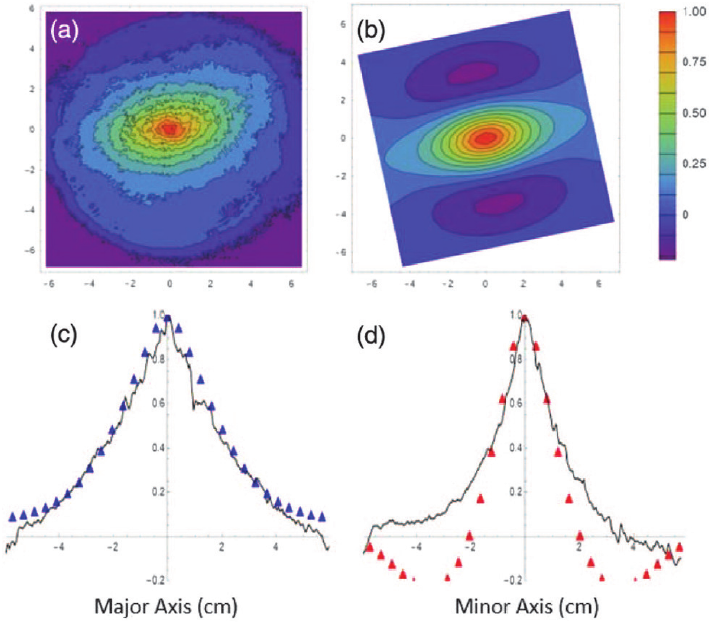
Figure 4. Experimental field measurements compared with theoretical results showing anisotropy ellipse of intensity covariance function: ( a ) measurement; ( b ) theory; ( c , d ) are major and minor cross-sections (solid curves: measurement; triangles: theory). Horizontal and vertical axes in ( a , b ) have extent ( − 6 cm, 6 cm). In ( c , d ) horizontal axes have extent ( − 6 cm, 6 cm) and vertical axes are unitless with range [ 0,1 ] . Reprinted with permission from Reference